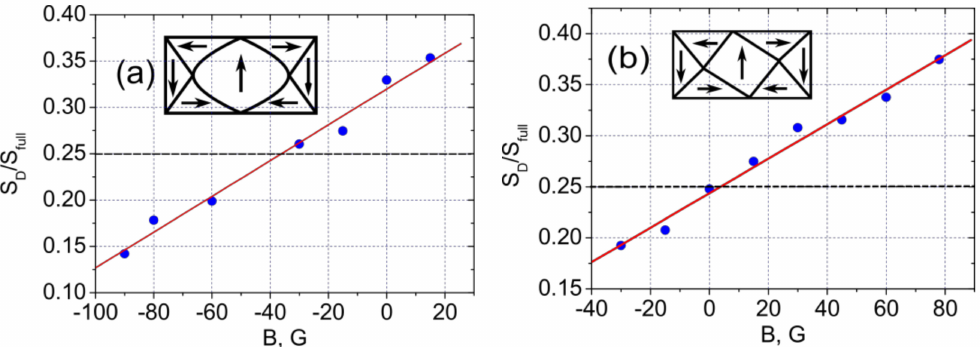
Figure 5. The dependence of the central domain of the rectangle areas ratio against the applied magnetic field. The magnetic field is directed along ( a ), and perpendicular ( b ) to the exchange built-in field. The inserts schematically show the domain structure in zero magnetic fields. The spatial distribution of magnetization and its direction have been taken from the micromagnetic calculations (see